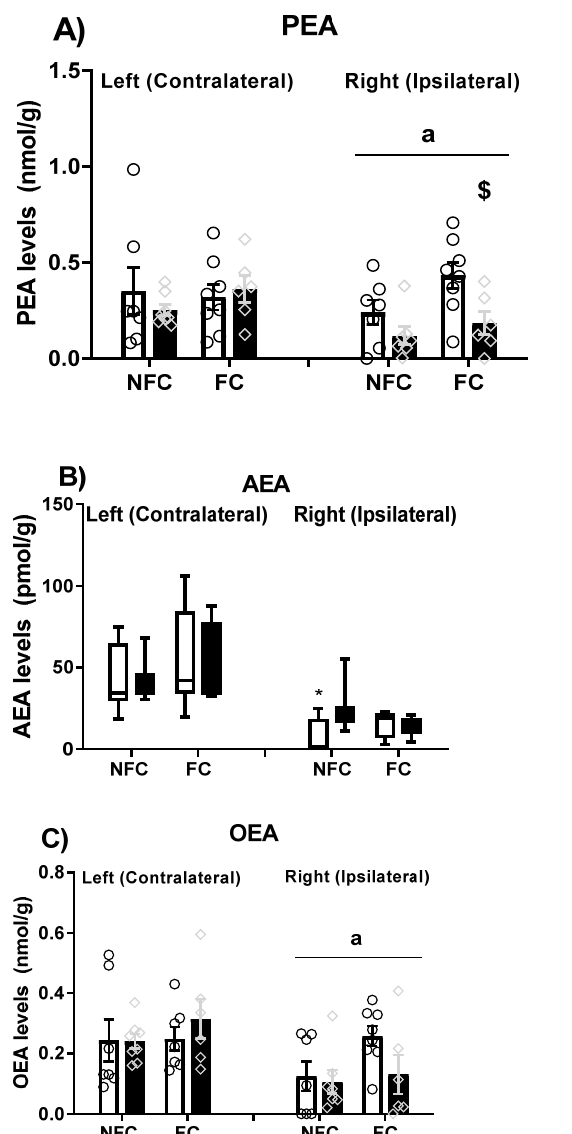
Figure 18. Effects of fear-conditioning and intraplantar injection of formalin on the levels of PEA ( A ), AEA ( B ), and OEA ( C ). Two-way ANOVA revealed a significant effect of side on PEA and OEA ( a p < 0.05). Post hoc pairwise analysis with Student Newman–Keuls indicated that FC rats that received formalin injection had lower levels of PEA in the right side compared to their saline-treated counterparts (FC formalin-treated vs. FC saline-treated, $ p < 0.05). Data are expressed as mean ± S.E.M ( A , C ) or median with interquartile range ( B ); each symbol represent one individual, n = 6–9 rats per group.